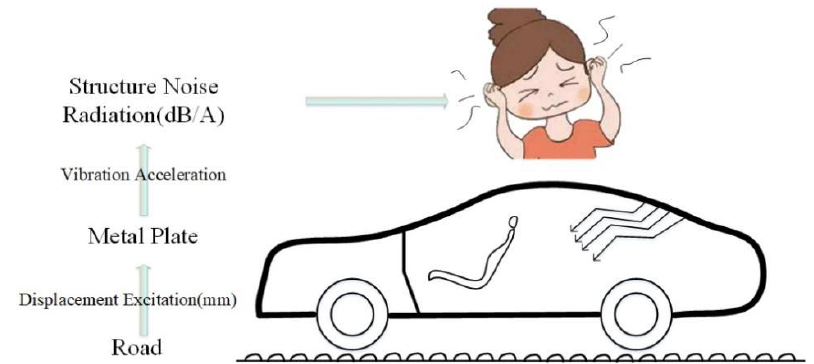
Figure 1. Noise radiation path of rough road structure